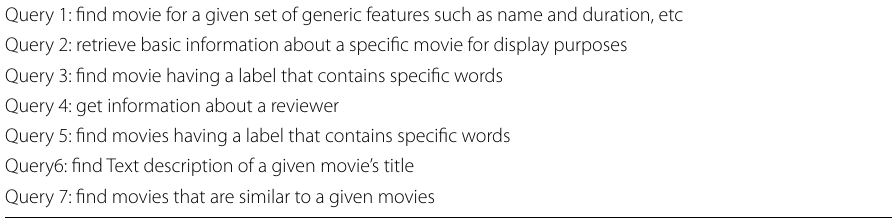
Table 5 A list of competency